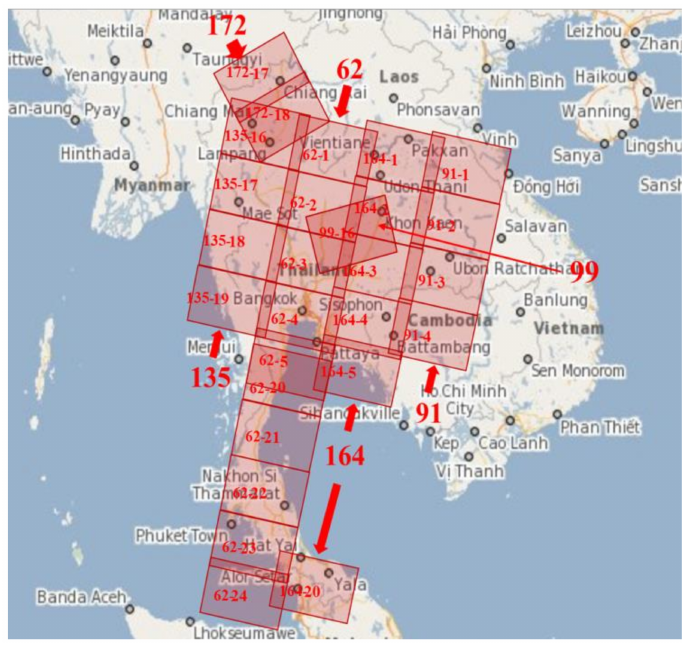
Figure 2. The location of the collected